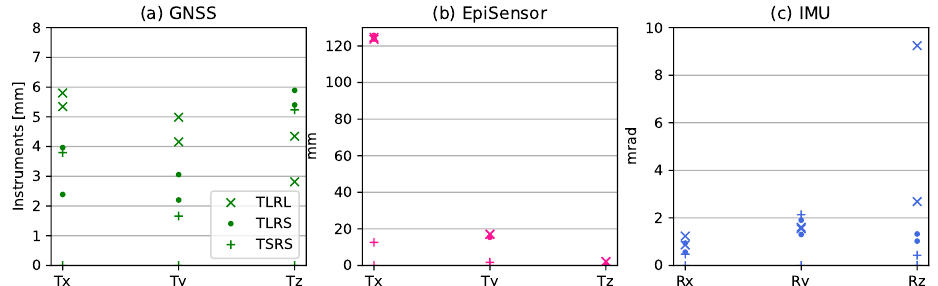
Figure 7. The RMSE values in comparison to the RFB for both repetitions of the three experiments in Tx, Ty, Tz. The GNSS positions plotted ( a ) are not corrected for the antenna offset rotation. The accelerometer data ( b ) is integrated twice, high-pass filtered at 0.09 Hz and not corrected for rotation of the instrument. The angular rate data ( c ) was integrated and high-pass filtered at 0.001 Hz. The subplots have different scales on the x -axis for better